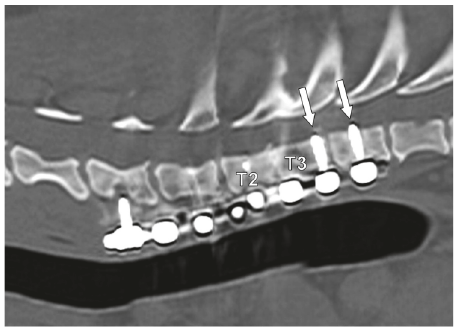
Figure 7: This image is a gap corrected reconstructed CT parasagit- talsliceofthedog’sspineeightweekspostoperatively.TheT2-T3disc space remained collapsed but the degree of luxation was consistent with preoperative imaging. The two caudal screws are noted to protrude slightly into the spinal canal (white